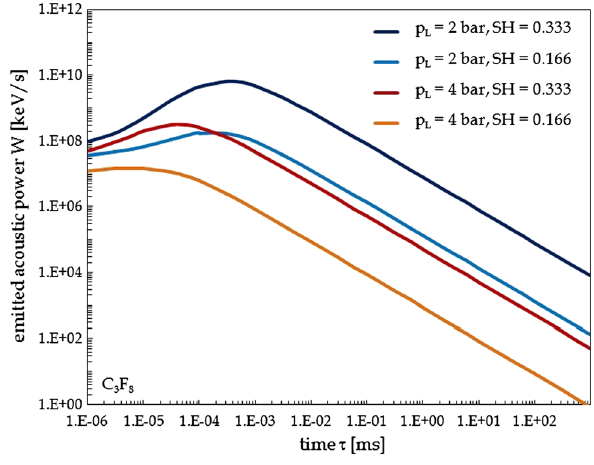
Fig. 3 Distributions of W vs. time at E c = 10 keV using p L as a parameter